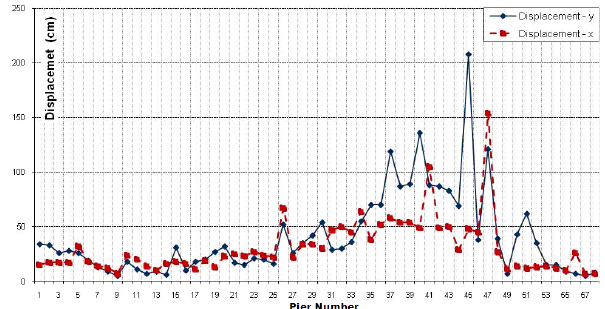
Figure 11. The measured peak displacements of the viaduct piers in x and y directions caused Fig. 11. The measured peak displacements of the viaduct piers in x- and y-directions caused by the D¨uzce earthquake. by the Düzce earthquake area = 14.30 m 2 , moments of inertias (longitudinal) 38.30 m 4 and 106.30 m 4 , modulus of elasticity for reinforced measured values are generally larger than the calculated values.